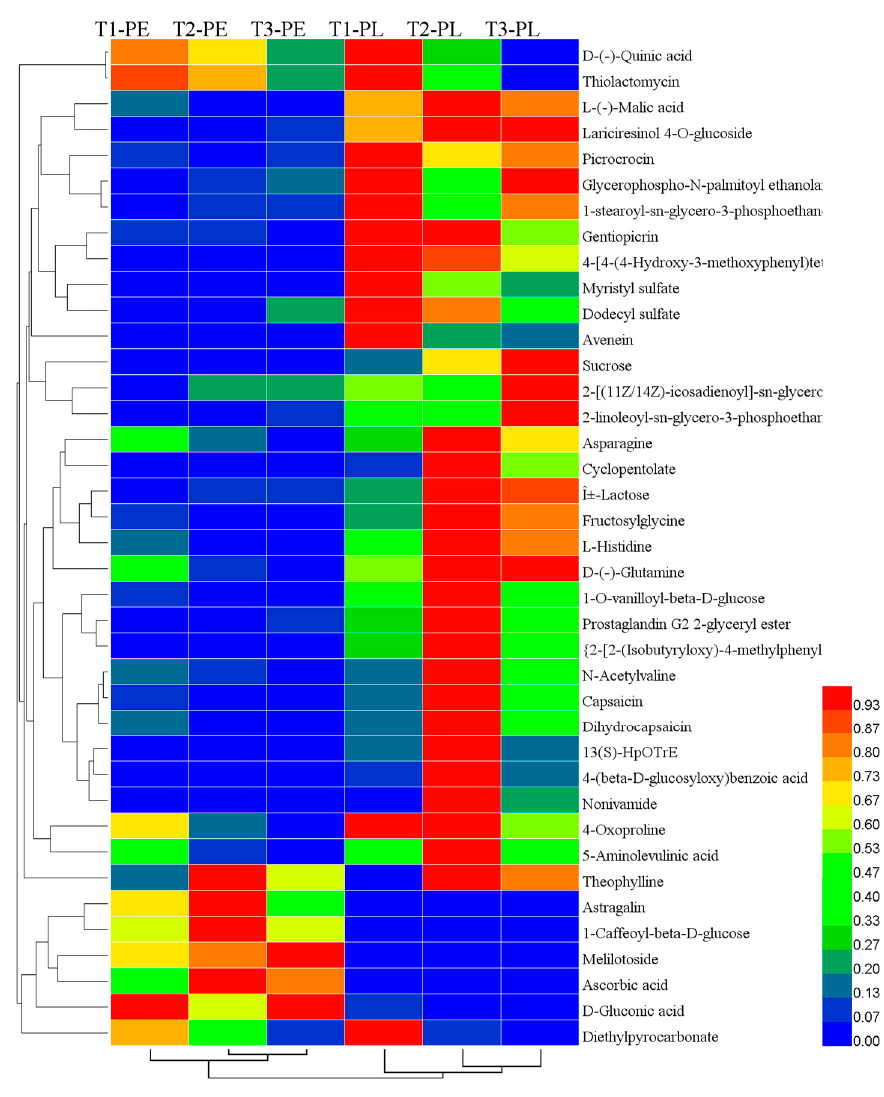
Figure 3. Hierarchical clustering of differential metabolites in pepper pericarp and placenta at different NH 4+ :NO 3 − ratios. T1, NH 4+ :NO 3 − = 0:100; T2, NH 4+ :NO 3 − = 25:75; T3, NH 4+ :NO 3 − = 50:50, PE, pericarp; PL, placenta. Euclidean distance and average linkage were used to construct the clustering of metabolites. The color block represents the relative expression of metabolites in the corresponding position.